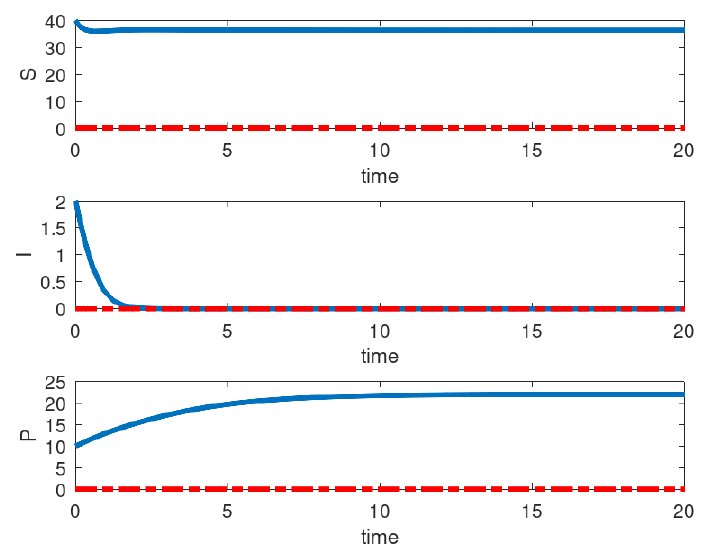
Figure 2. E 4 can be attained with the parameters in (21) and initial conditions (22). The red dashed line indicates the zero value.